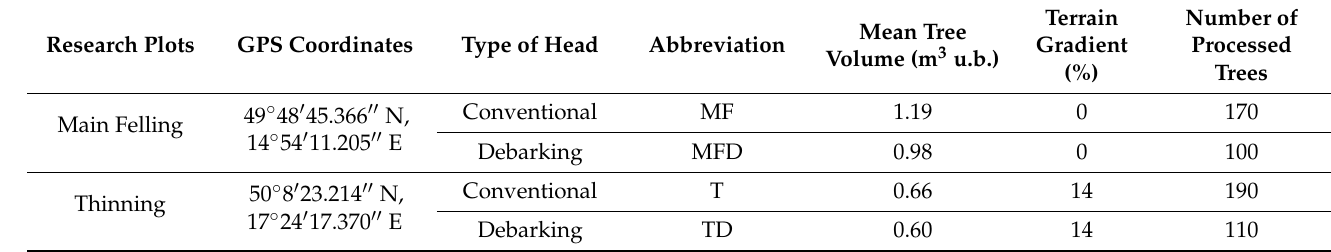
Figure 1. Location of the research plots. Table 1. Basic information on the research